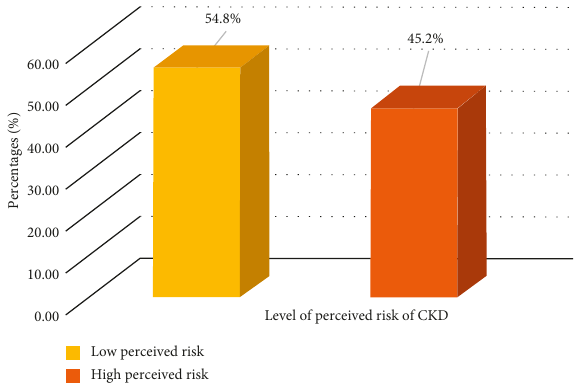
Figure 4: Level of perceived risk towards CKD ailments among